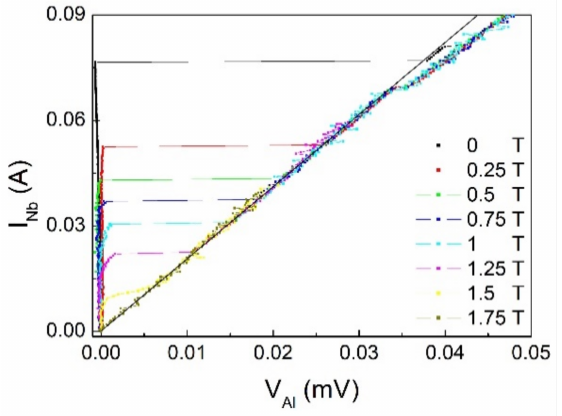
Figure 5. I–V curves at T = 4.2 K at different value of the magnetic fields for a Nb/Al bilayer with current sent in